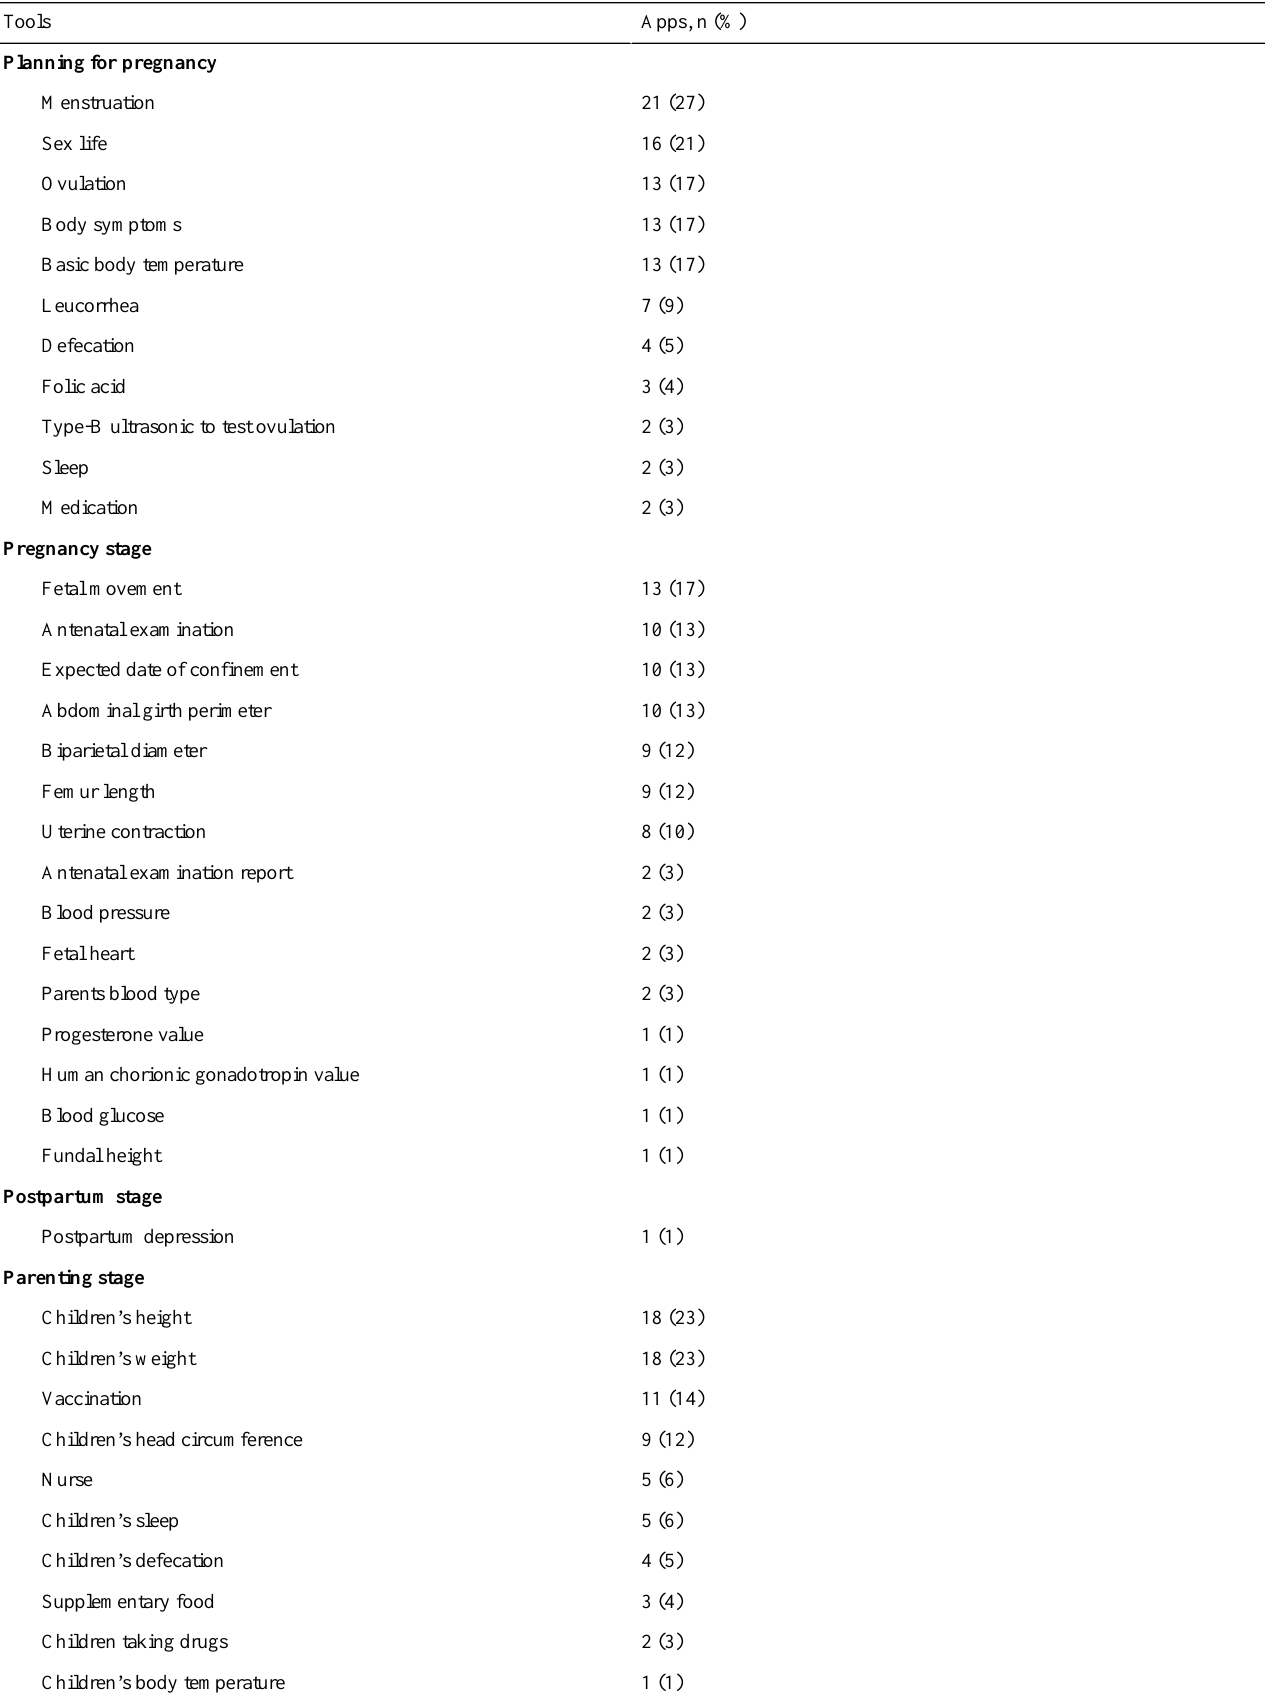
Table 2. Specific tools within the “health status self-monitoring” feature found in the 78 popular apps on maternal and child